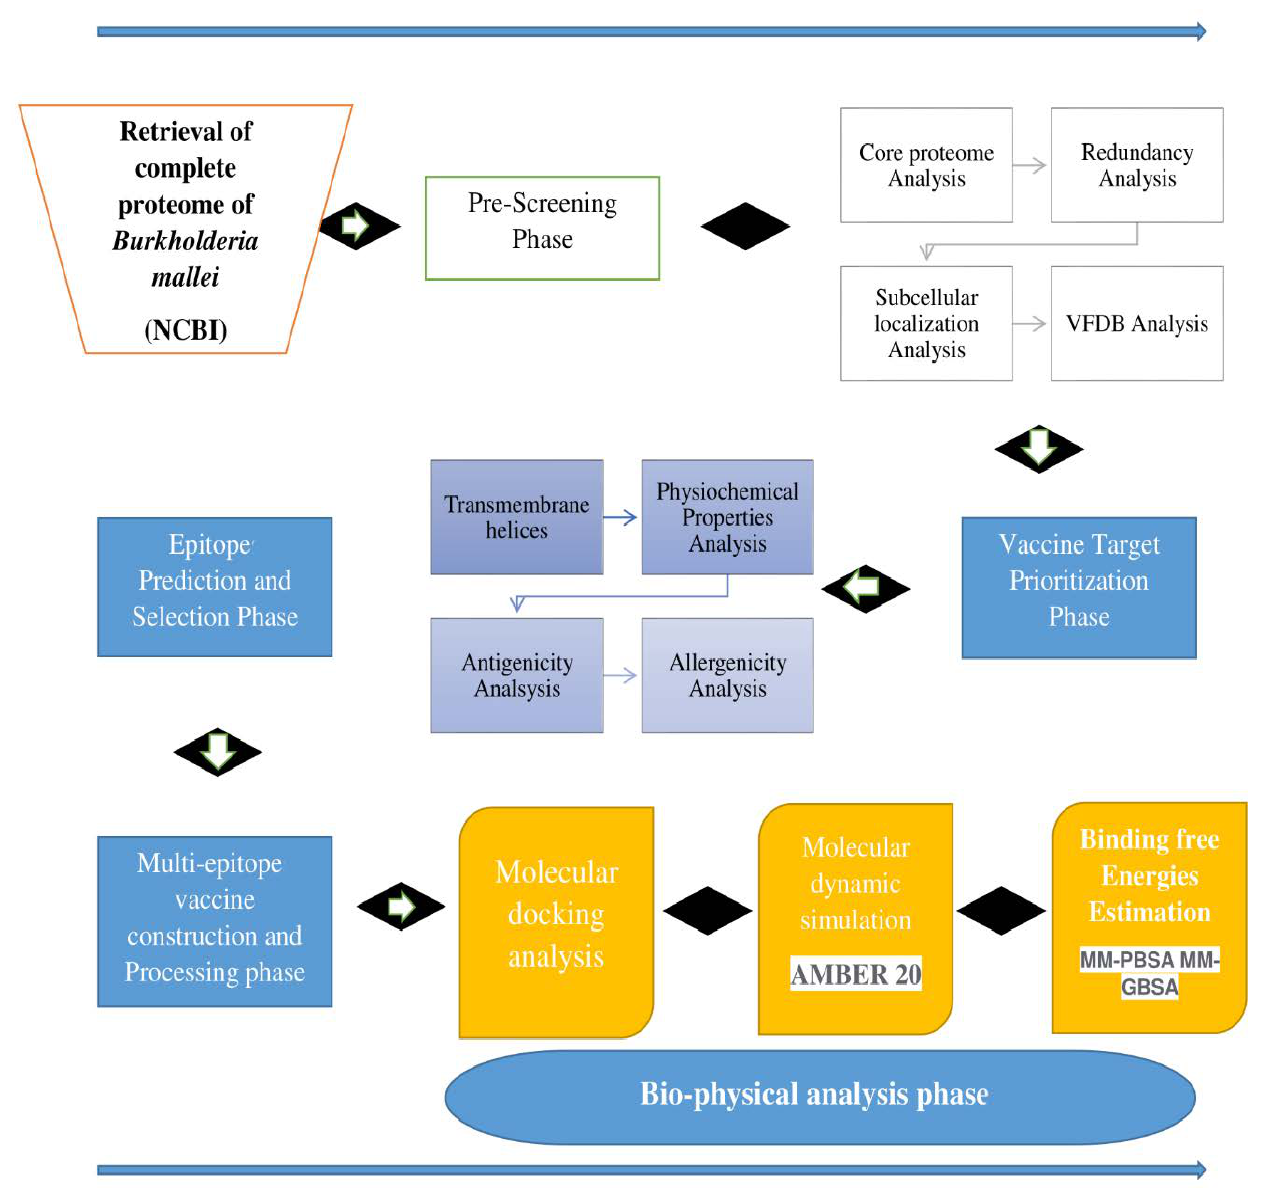
Figure 1. Schematic representation of research methodology followed for vaccine construction against B. mallei